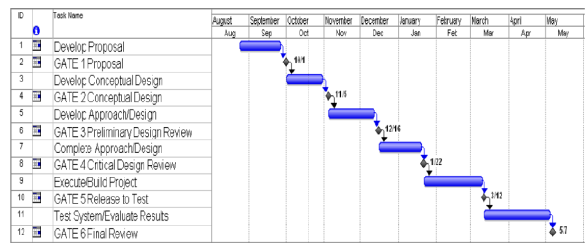
Figure 2. Typical timeline for senior capstone design